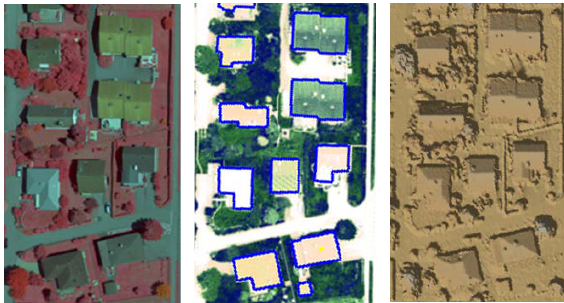
Figure 9. False colour orthoimage, NDVI map and shaded